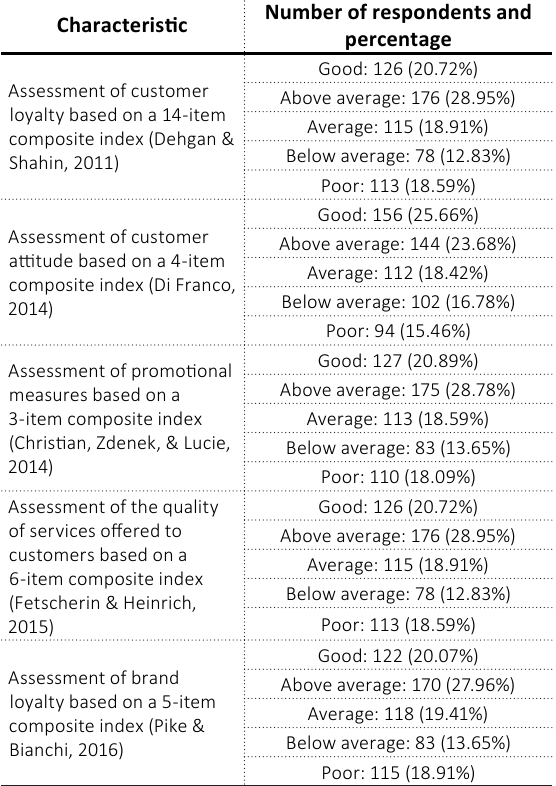
Table 6. Cronbach Alpha coefficients for